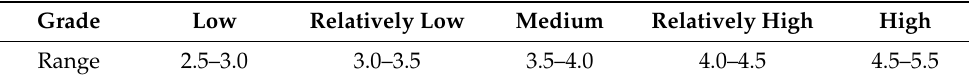
Table 2. The higher the DASTIC-LD R indicator is, the greater the groundwater vulnerability is. Table 2. The range of each grade for groundwater vulnerability. Grade Low Relatively Low Medium Relatively High